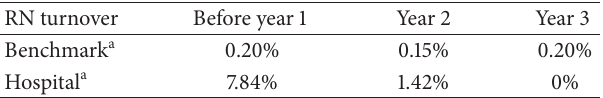
Table 5: RN voluntary